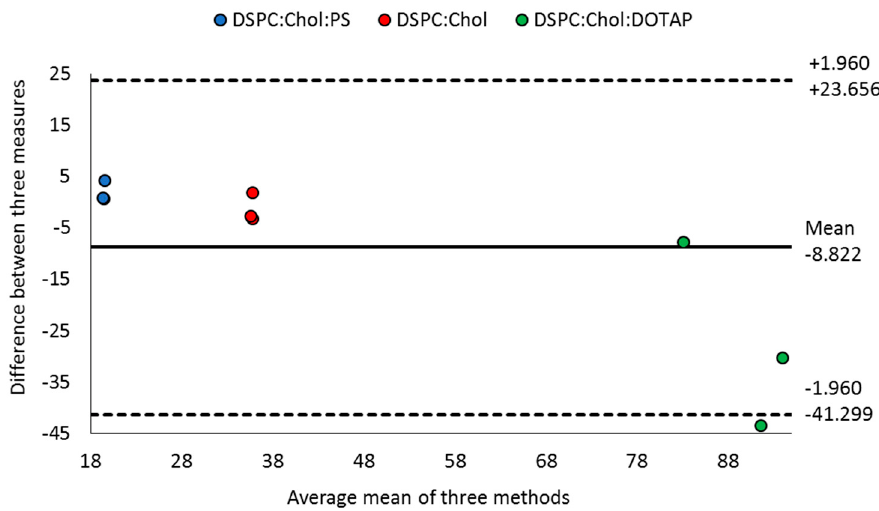
Figure 6. Bland and Atlman plot analysis for the comparison of three analytical techniques. Plot of differences between three analytical techniques (RP-HPLC, HPLC-ELSD and BCA assay) on the y-axis, versus the mean of the three analytical techniques for the three formulations (DSPC:Chol, DSPC:Chol:PS and DSPC:Chol:DOTAP). The calculated mean is − 8.8 (horizontal solid line), with the bias represented by the gap between the mean and the dashed lines. All formulations were measured three times for the encapsulation efficiency, with each measurement plotted.